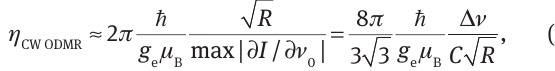
relaxometry: phonon-limited T decay rate (blue) is increased (red) by 1 1